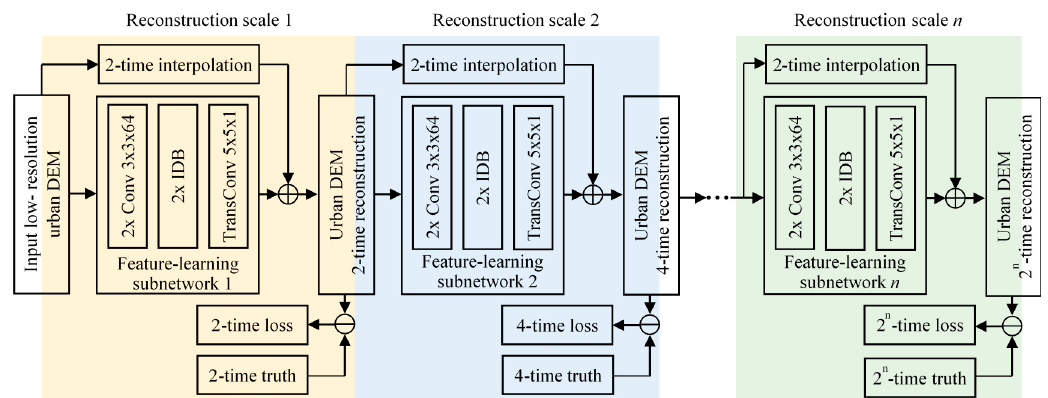
Figure 1. A multi-scale gradual network of multi-scale mapping approach based on convolutional neural network (MSM-CNN), in which IDB denotes the information distillation block as detailed in Figure 2; the symbols ⊕ and ⊖ represent the element-wise sum and loss-calculation operators, respectively; Conv and TransConv denote the convolutional and transposed convolution layers; the expression 2x Conv or 2x IDB represents two convolutional layers or two IDBs; and the size of convolutional or transposed convolution layers is in the format of width by height by number of filters (also referred as neurons or kernels), e.g., 3 × 3 × 64.